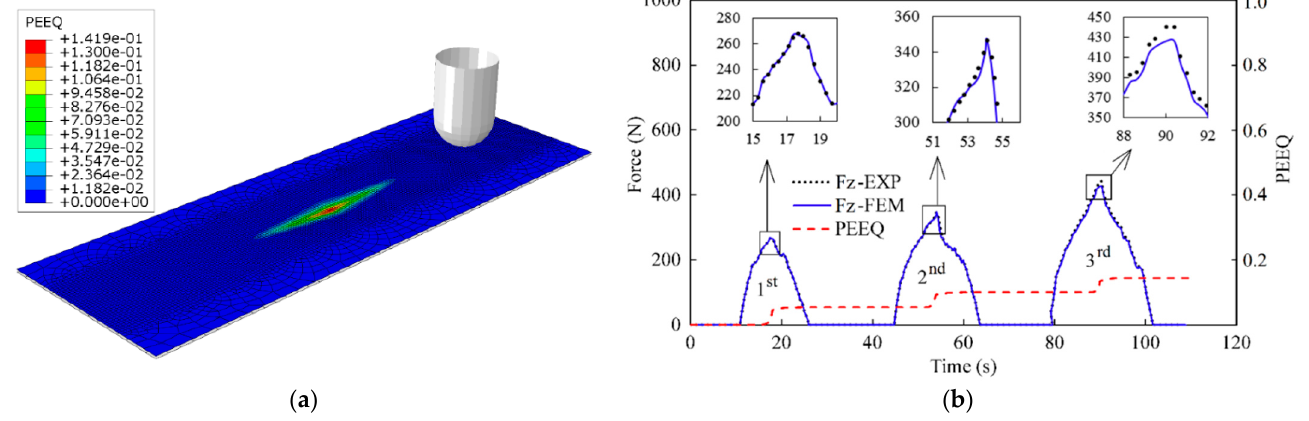
Figure 6. ( a ) The formed part after 3rd depth increment in the FEM. ( b ) Force Fz prediction by FEM using stress–strain curve in uniform deformation range.